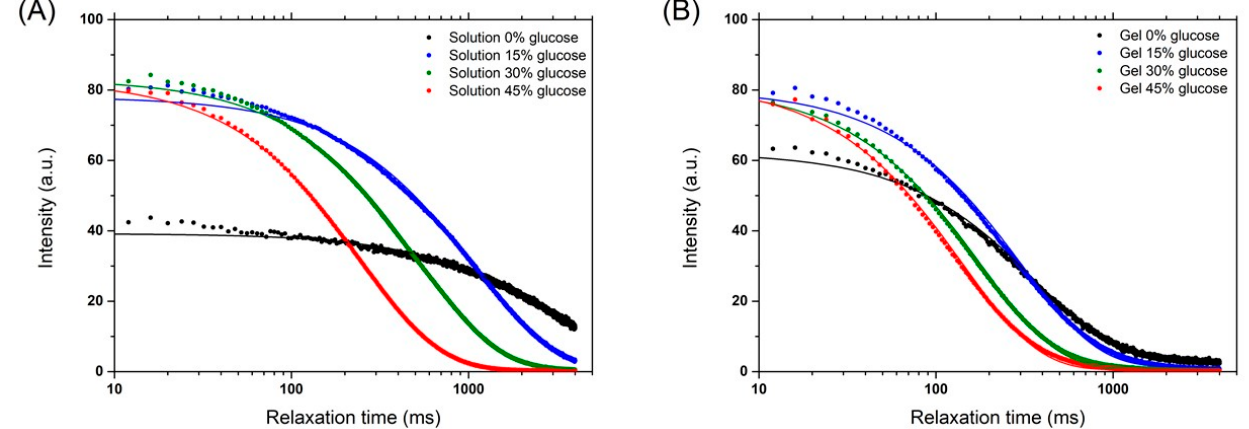
Figure 1. NMR CPMG signal for alginate solution ( A ) and calcium-alginate hydrogels ( B ) with different glucose concentrations (0, 15, 30, and 45 wt %). Lines represent the fit of experimental data by using one single exponential, as shown in Equation (5). Notice that the intensity at low relaxation times is the same for all glucose samples due to saturation of the signal.